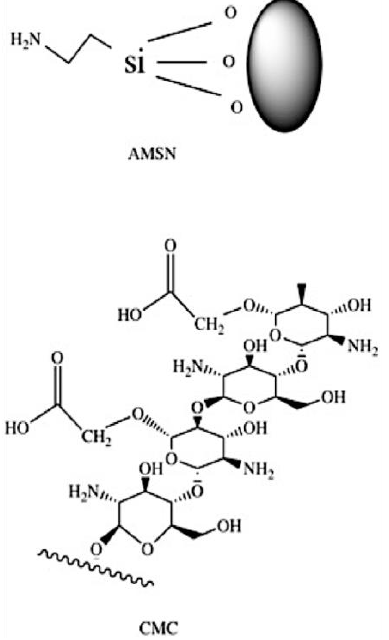
Figure 3. Chemical structure of AMSN and CMC.